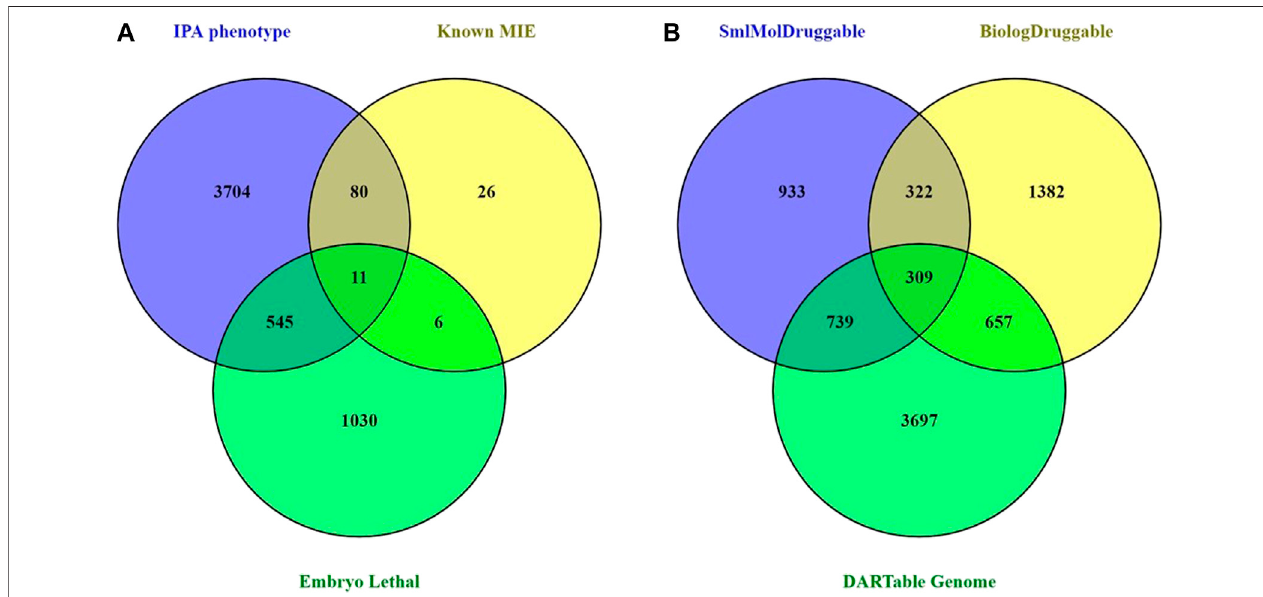
FIGURE1| CurationandAnalysisofDARTableGenomeandComparisontotheDruggableGenome. (A) Theoverlapanddifferencesbetweenthemembershipsof each component source of the hypothetical DARTable genome was determined. Count represents a unique gene symbol. (B) The overlap between the hypothetical DARTable genome and the Druggable genomes from Finan et al., 2017 was determined.